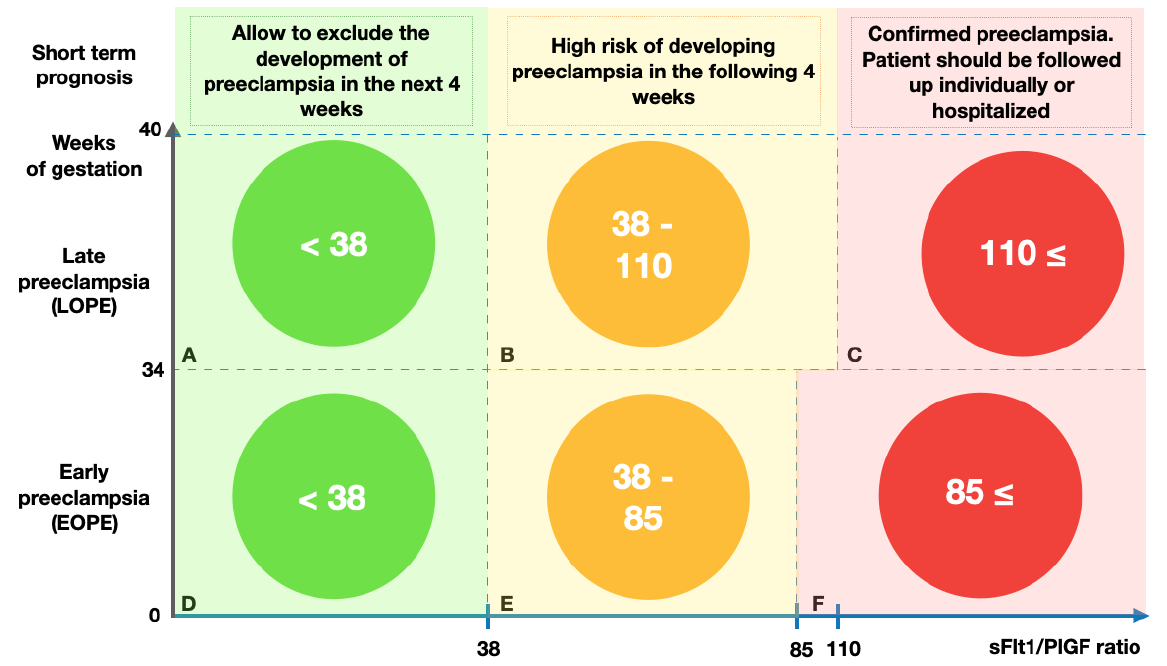
Figure 2. Using the sFlt1/PlGF ratio for short-term prediction and confirmation of pre-eclampsia. ( A ). Week of gestation > 34 and the sFlt1/PlGF ratio < 38 allow excluding the development of LOPE in the next 4 weeks. ( B ). Week of gestation > 34 and the sFlt1/PlGF ratio 38 – 110 indicate a high risk